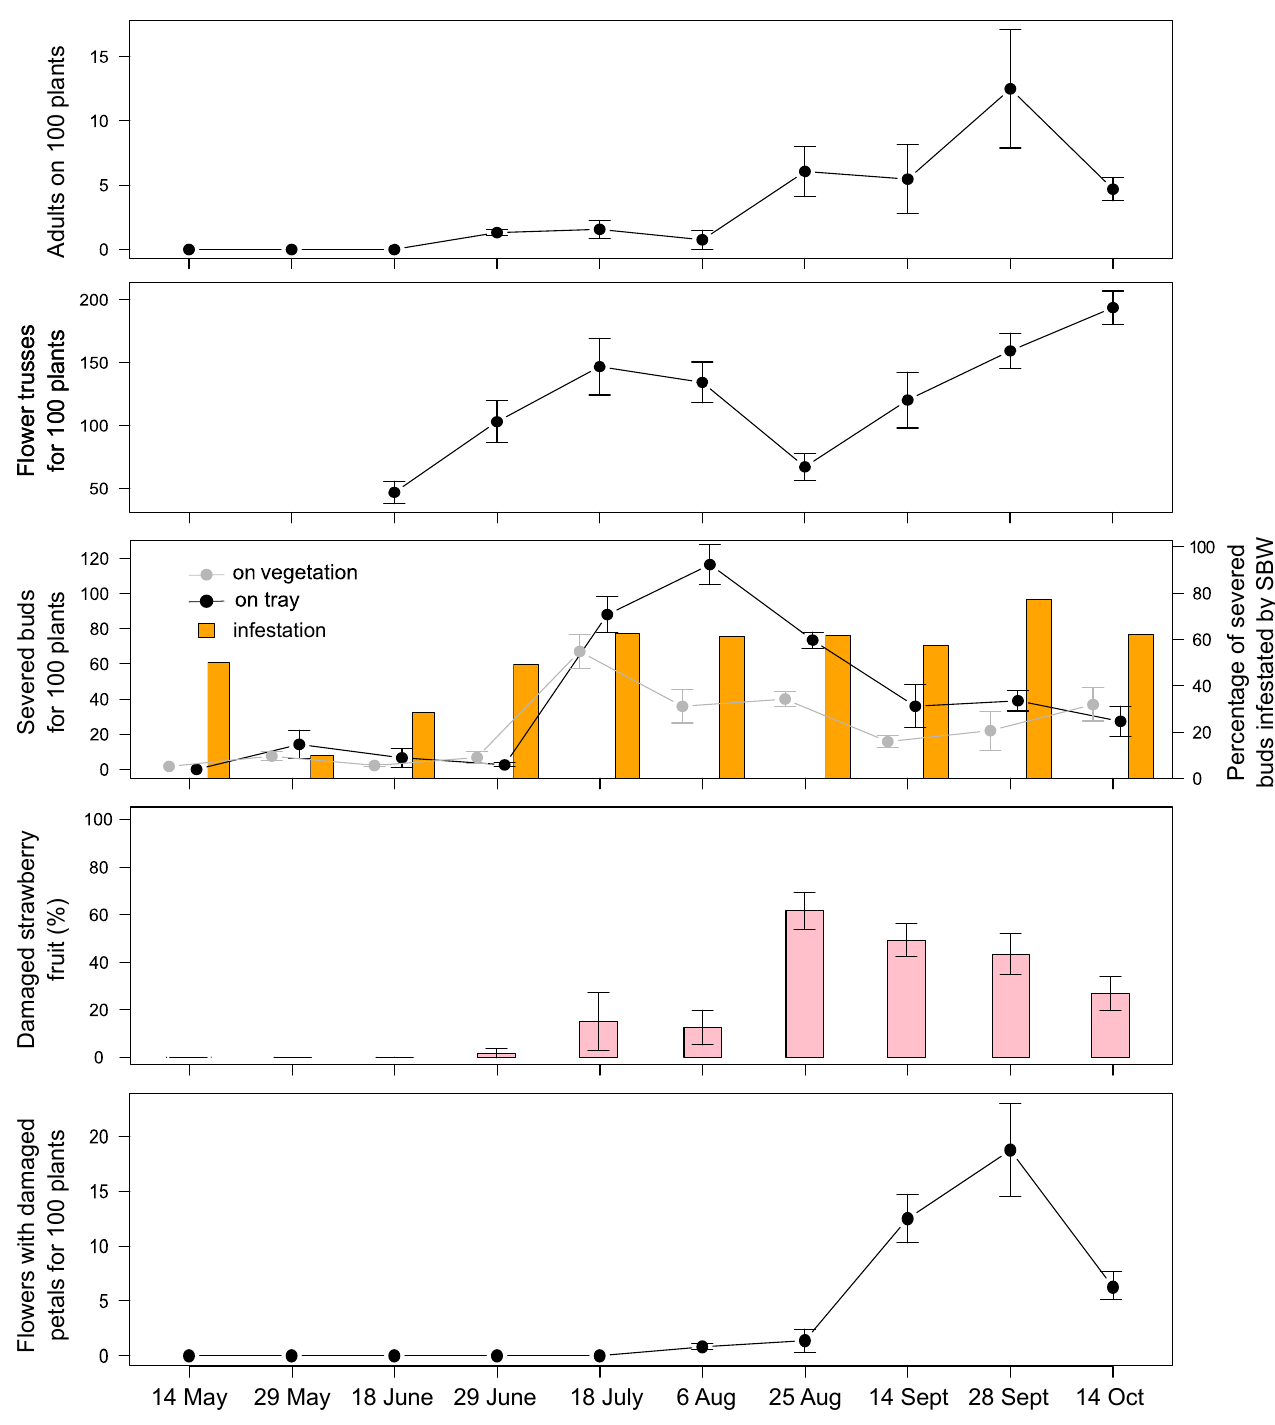
Figure 4. SBW adults, flower trusses, severed strawberry flower buds on vegetation and on tray substrate surface, percentage of infestation, white-rose fruit damage, and flowers with damaged petals during the 2020 season in the fields of Drena. Error bars indicate standard error.